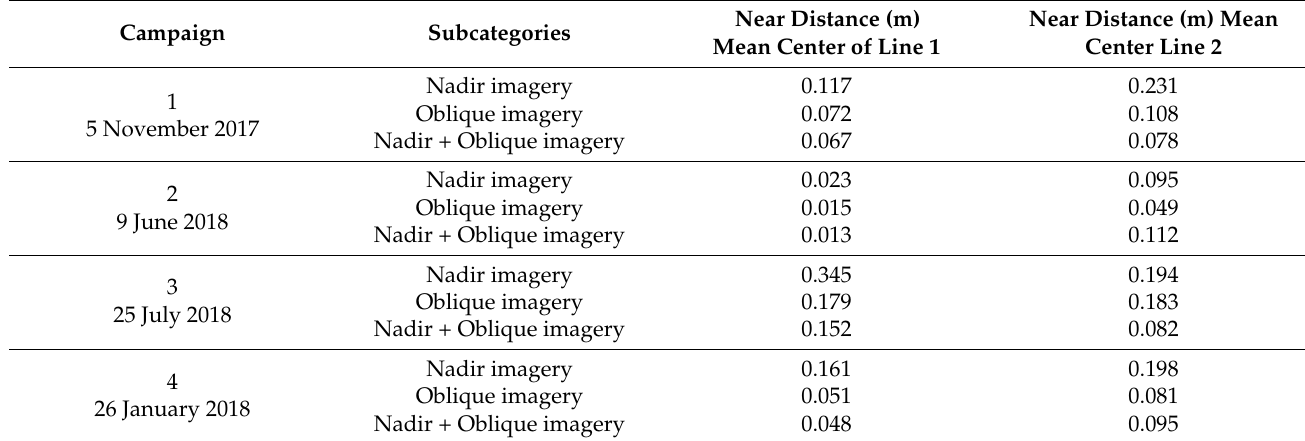
Table 6. Near distances of mean centers from the reference mean centers of lines 1 and 2.